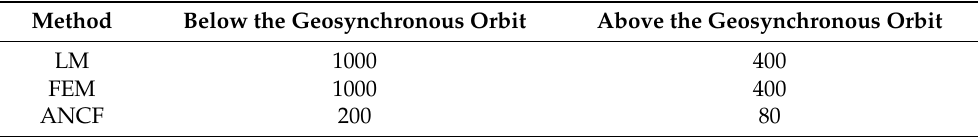
Table 2. Element number of each